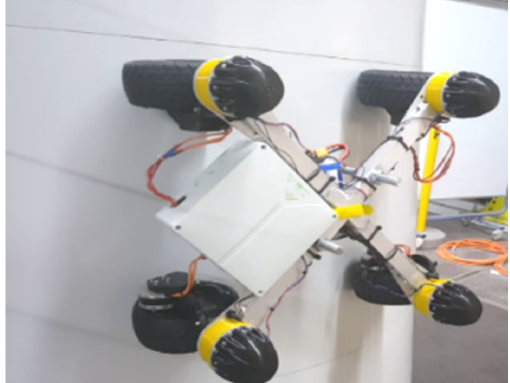
Figure 17. Magnetic platform.